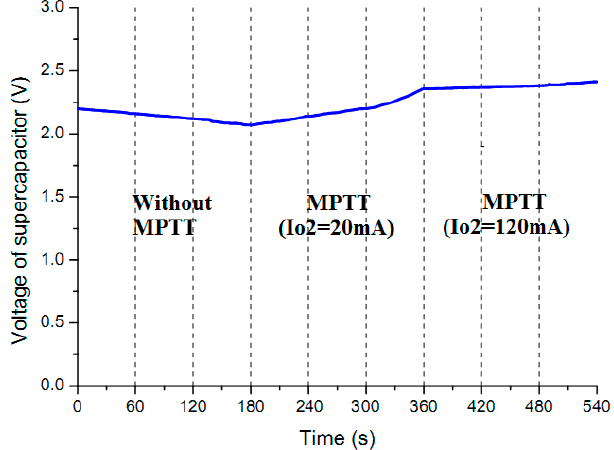
Figure 8. Voltage variation of supercapacitor under three different operation modes.